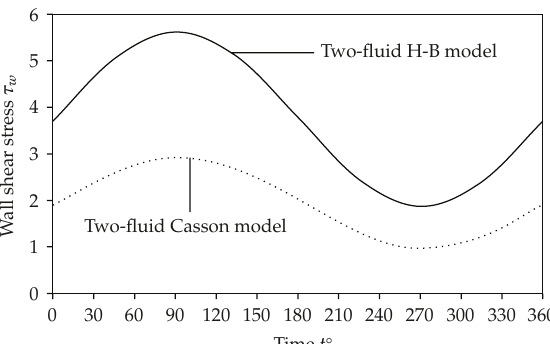
Figure 5: Variation of wall shear stress in a cycle of the two-fluid Casson and two fluid Herschel-Bulkley models.